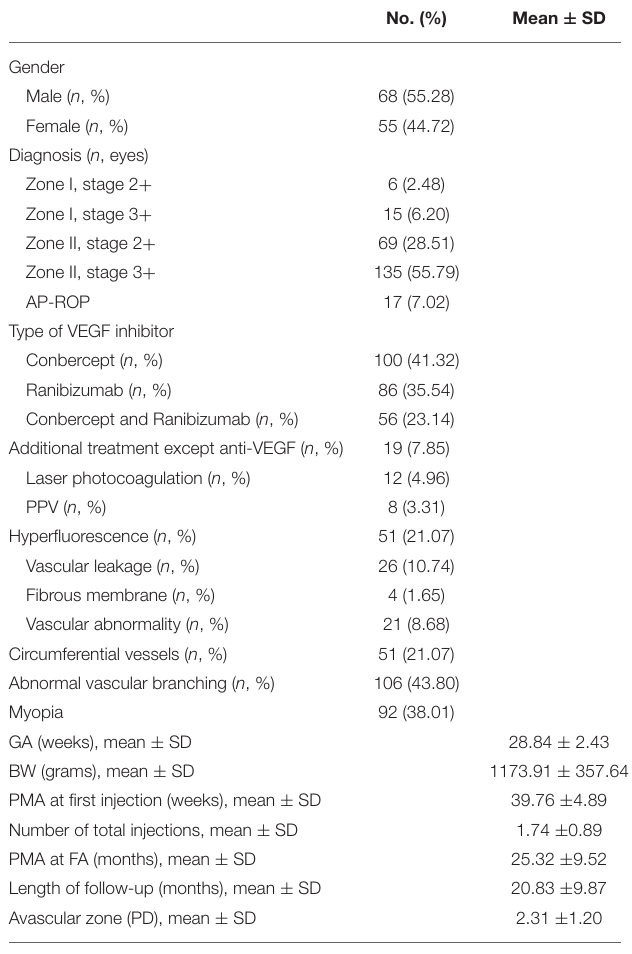
TABLE 1 | Demographic, clinical, and FA characteristics for included patients with